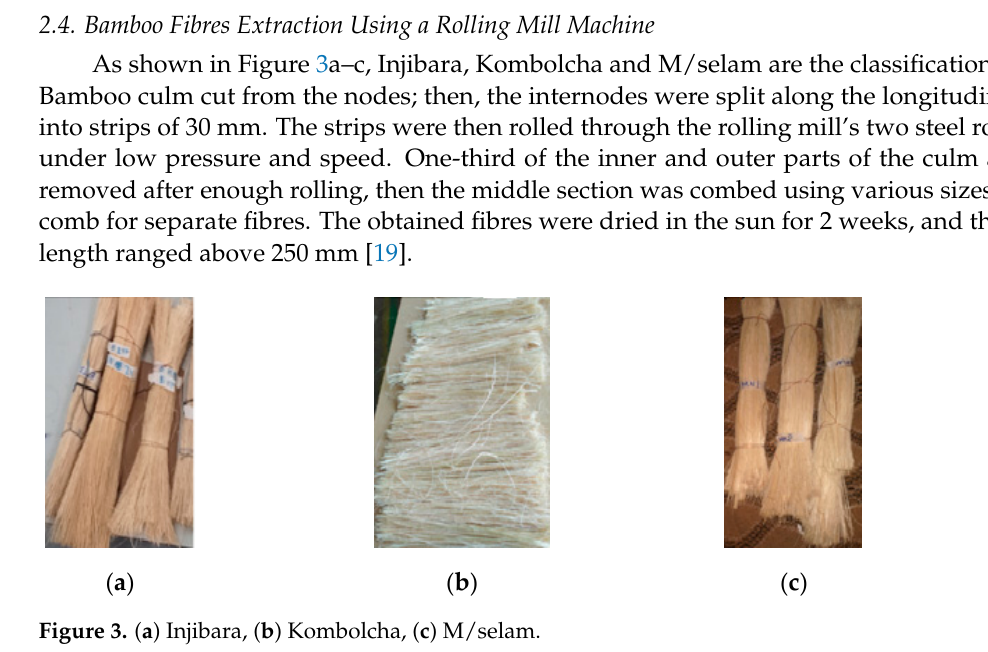
Figure 2. Sample taking techniques of the bamboo culm.